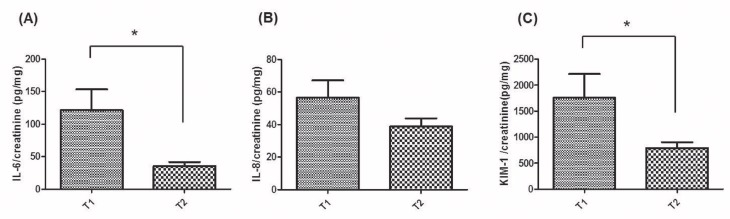
1,25(OH)2D3 and urine inflammatory cytokine level in urine from kidney transplant recipients.The production of (A)
IL-6/creatinine, (B)
IL-8/creatinine
(C)
KIM-1/creatinine was measured using ELISA in urine from kidney transplant recipients. We divided patients group into two groups based on serum 25(OH)D level; Low 25(OH)D group (25(OH)D <20 ng/mL, T1 (n = 40)), Normal 25(OD)D group (25(OH)D > 20 ng/mL, T2 (n = 50)) from kidney transplant recipients. Bars show the means. * P<0.05 vs. T1.